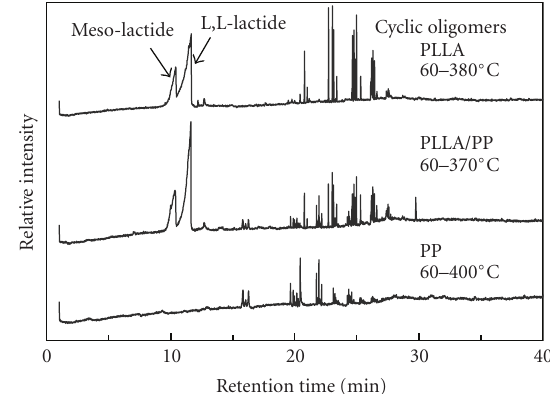
Figure 2: Thermogravimetric analysis ( ϕ = 9 ◦ Cmin − 1 ) of PLLA/PP and PLLA/PP/MgO blends. w : residual weight ratio of PLLA/PP components.